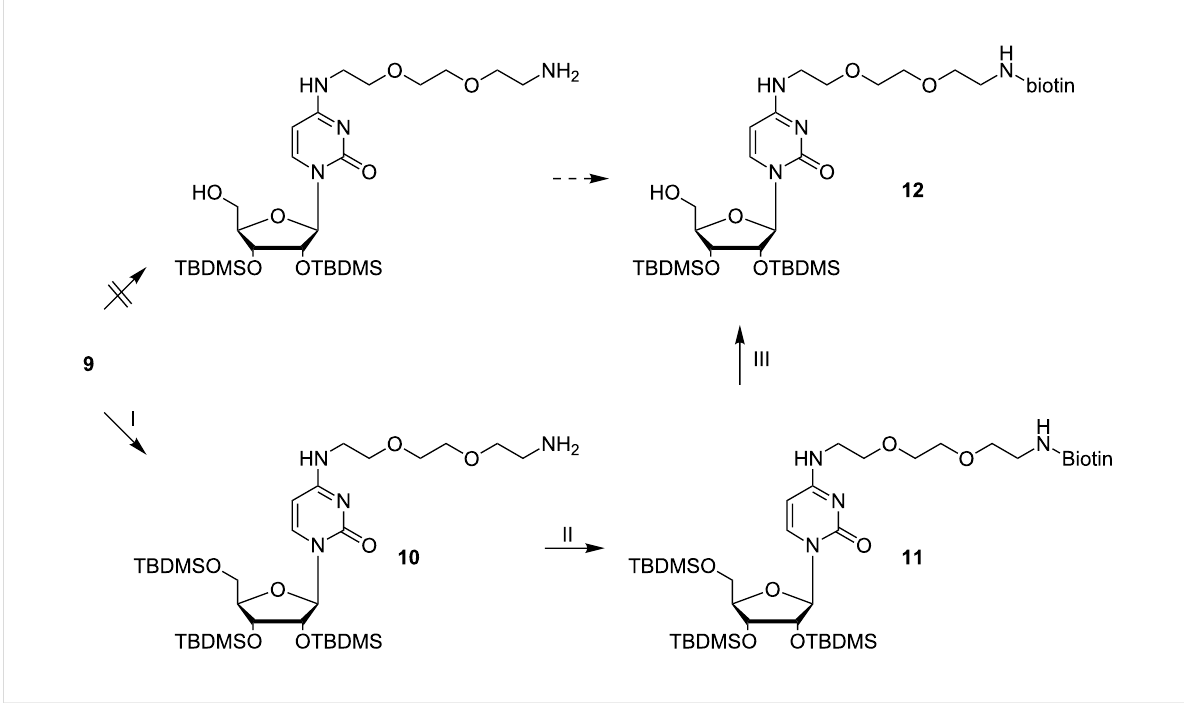
Figure 4: Synthesis of 2',3'-bis- O -( tert -butyldimethylsilyl)-1-[4-( N '-biotinyl-3,6-dioxaoctane-1,8-diamine)pyrimidine-2(1 H )-onyl]- β -D-riboside ( 12 ). I: 2.6 equiv ZnBr 2 , DCM, 1 d, rt, Ar, 82%; II: 1.1 equiv EDAC·HCl, 1.1 equiv biotin, DMF, 0 °C → rt, overnight, 65%; III: THF/TFA/H 2 O (4:1:1, v/v/v), 0 °C, 5 h,